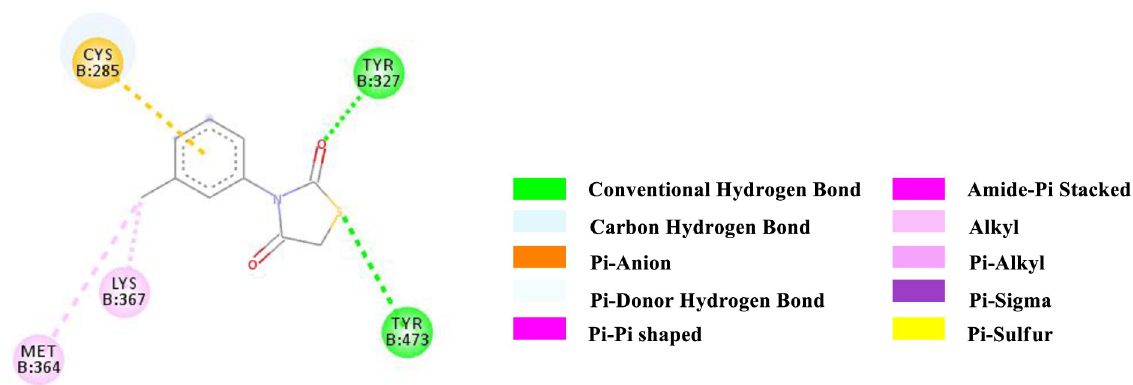
Fig 4. 2D-representation of the non-covalent interactions of 4 and receptor (3gbk) after flexible docking.